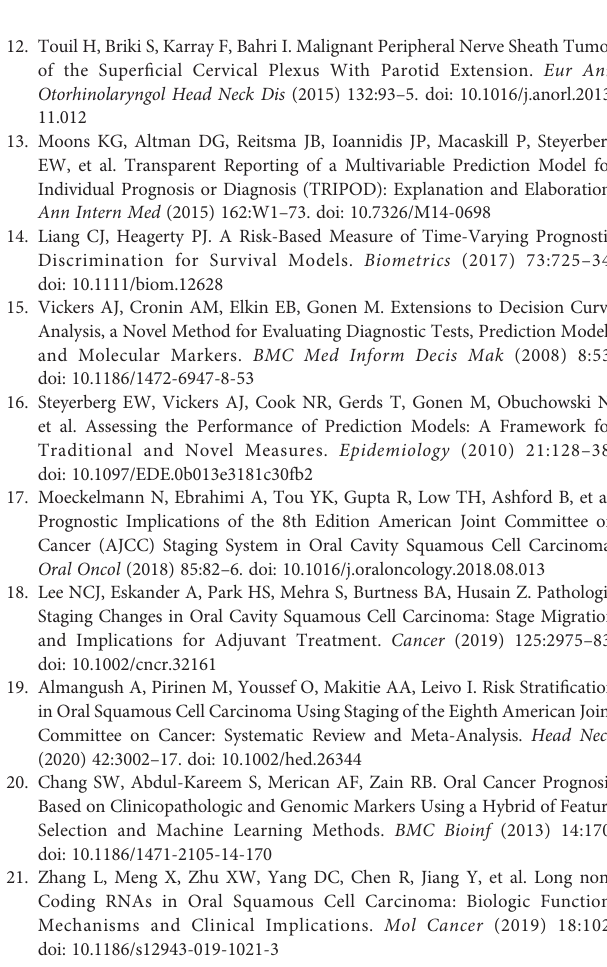
Supplementary Figure 1 | Nomogram based on the pathological model for the prediction of 1-, 3- and 5-year OS. P-T, pathological tumor stage; P-N, pathological nodal involvement stage; OS, overall survival. Supplementary Figure 2 | Performance of the pathological model. ROC curve (A – C) , calibration curves for 1-year OS (D – F) , calibration curves for 3-year OS (G – I) , and calibration curves for 5-year OS (J – L) for the training (A, D, G, J) , internal validation (B, E, H, K) and external validation cohorts (C, F, I, L) . Supplementary Figure 3 | The ROC curves based on the AJCC TNM staging system for the prediction of 1-, 3- and 5-year OS in the training (A) , internal validation (B) , and external validation cohorts (C)